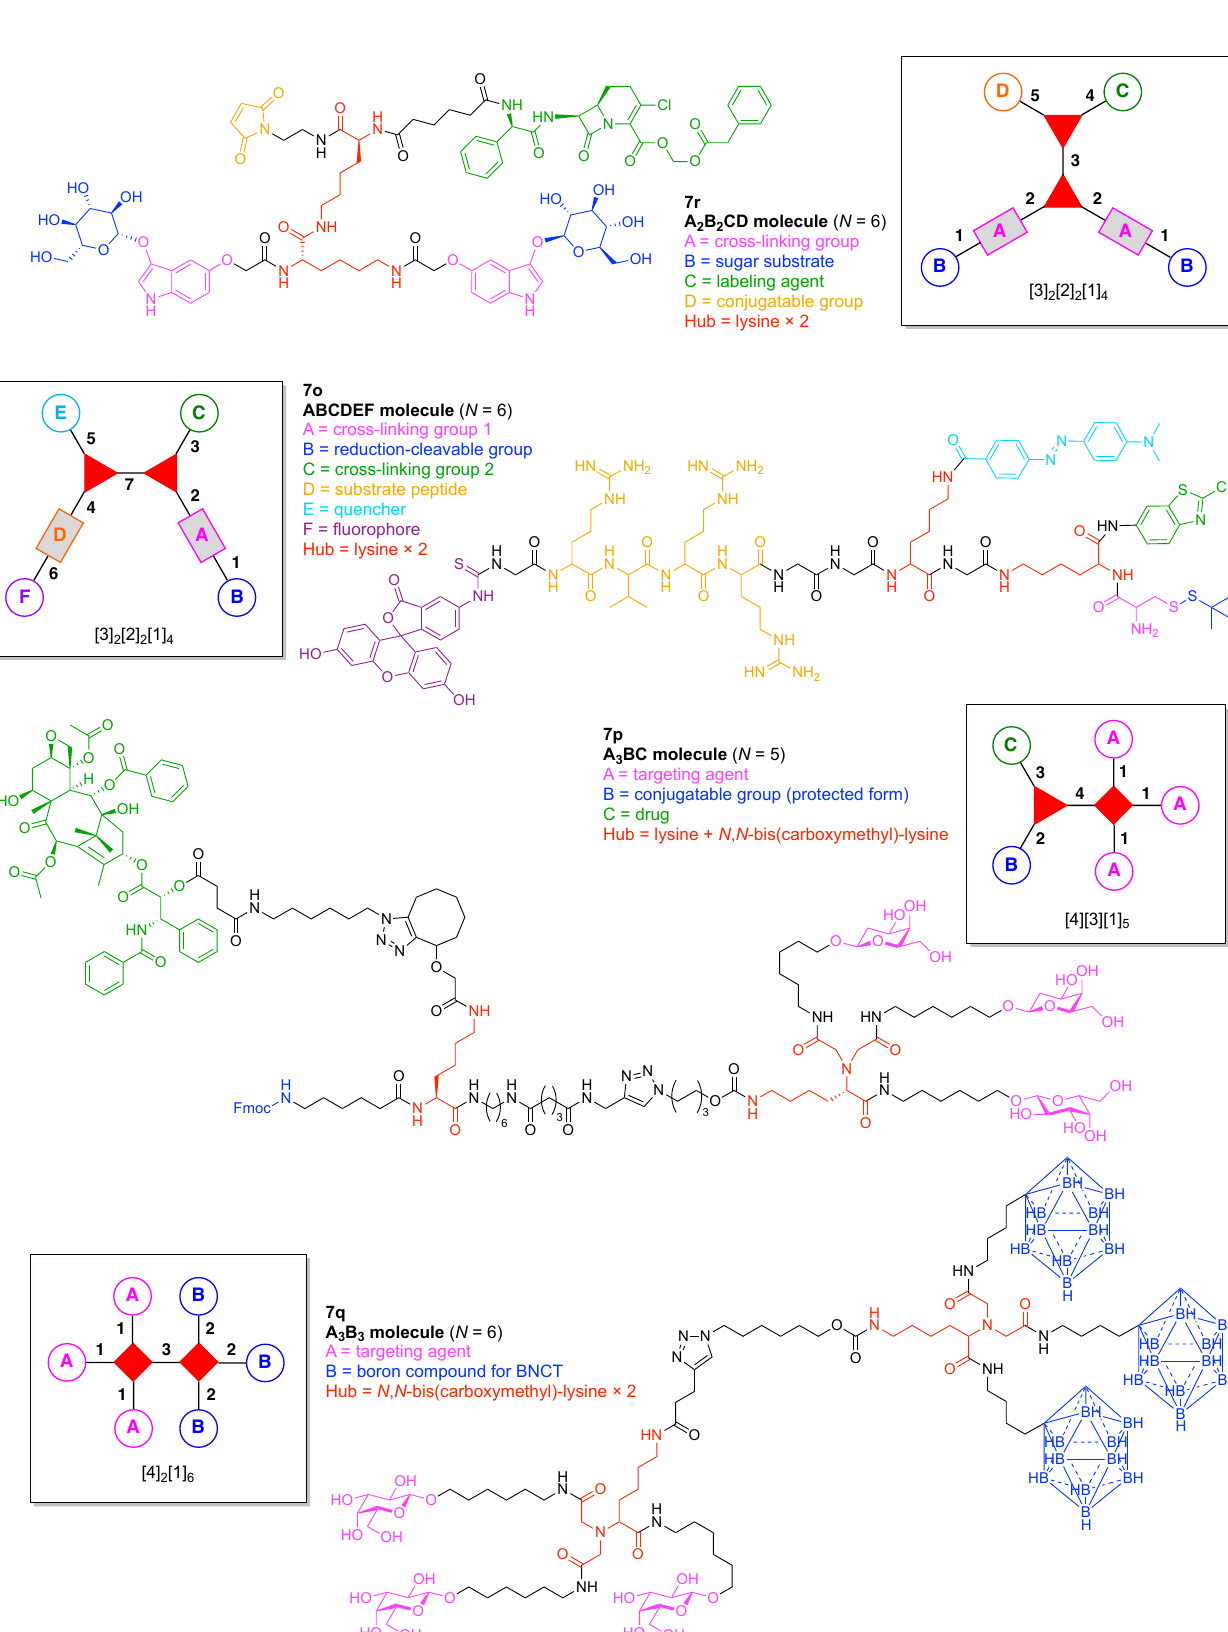
B = boron compound for BNCT Hub = N , N -bis(carboxymethyl)-lysine × 2